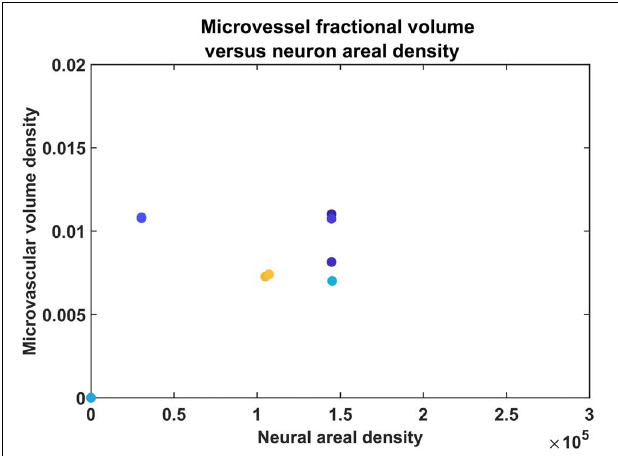
FIGURE 10 | The scatter plot between neural areal density and microvascular volume density of different